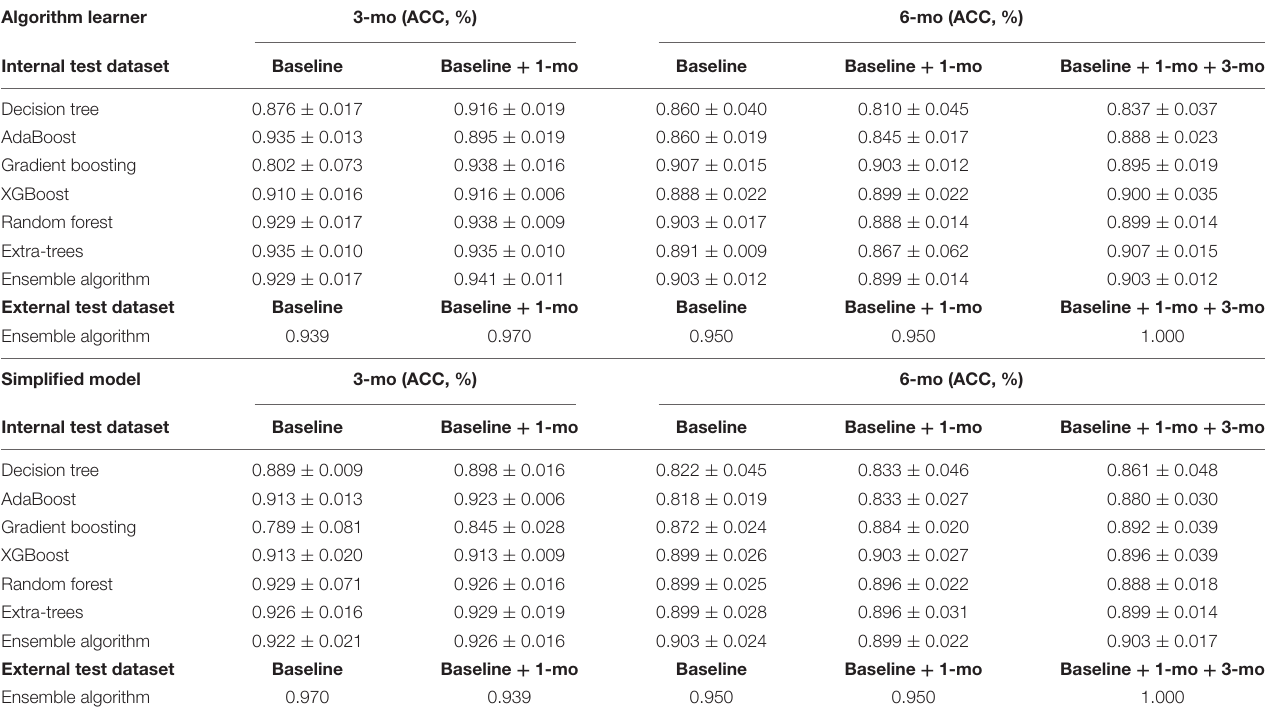
TABLE 2 | Accuracy of the Recurrence Predictions in the internal test dataset and the external test dataset. Algorithm